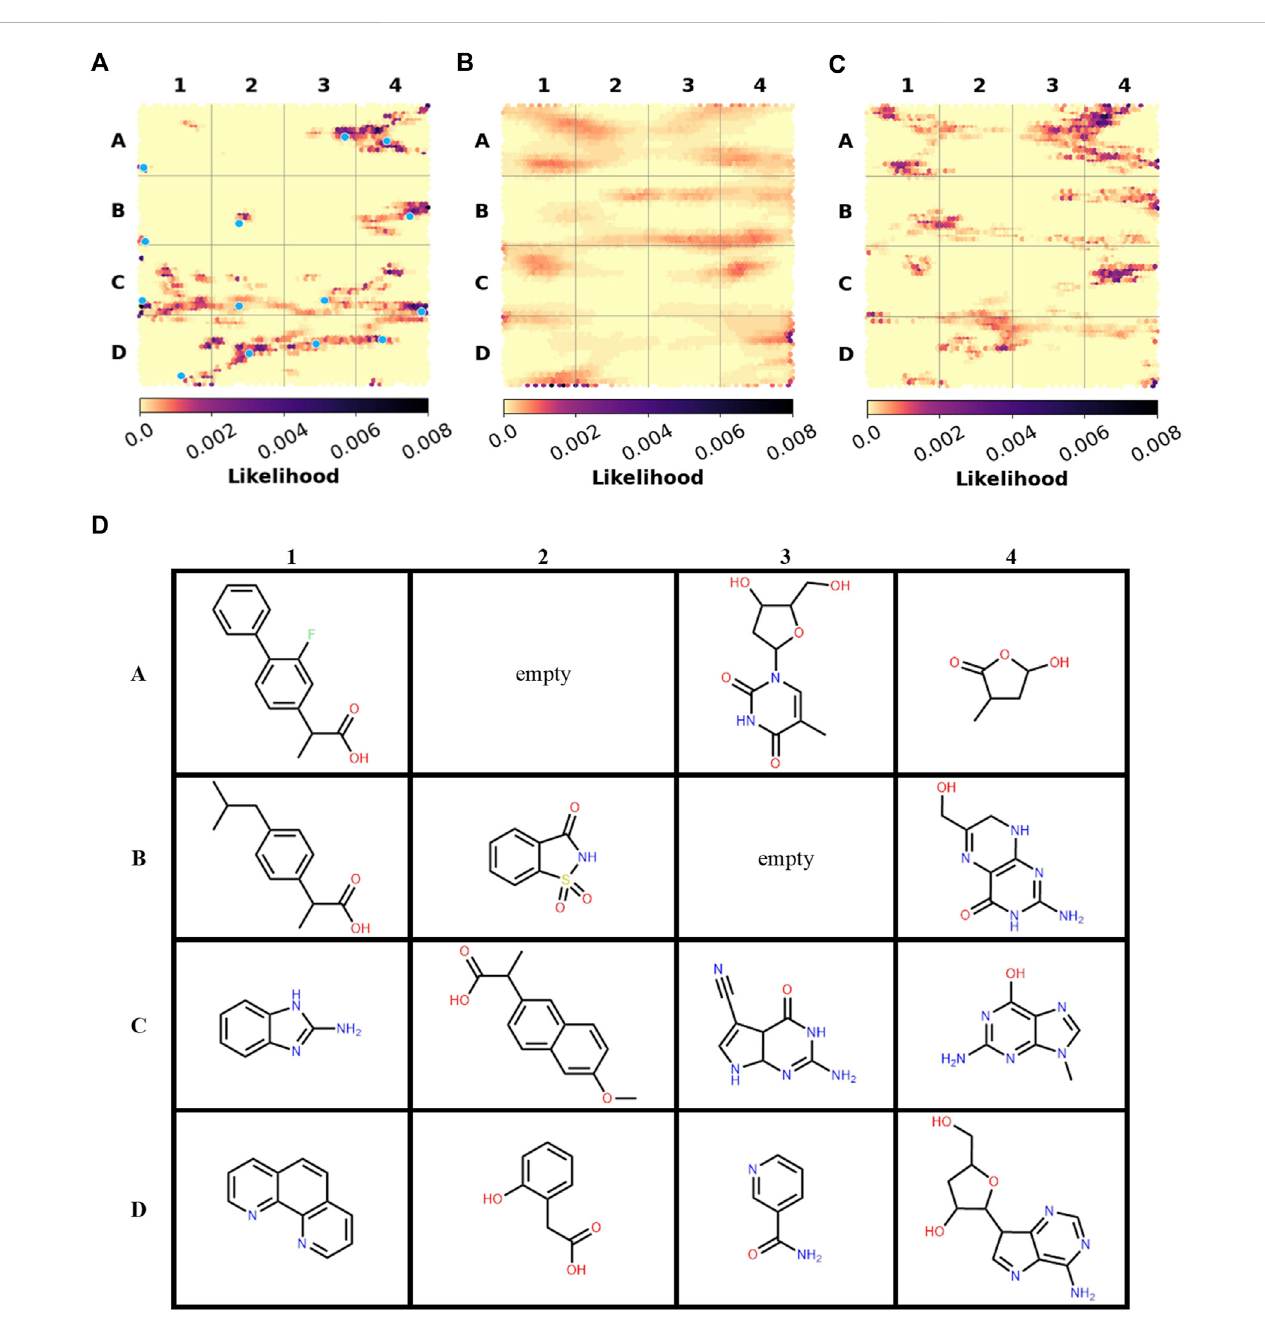
FIGURE 5 Spatial distribution of the fragments in GTM Landscapes (A) Versatile PDB fragments (B) All commercially-available fragments (C) Ensemble of nature- productlikecommercial libraries. (D) ExamplesofversatilePDBfragments.Theirprojectionpointsaremarkedwithbluedotsonthemap (A) .Figures5B,Care adapted from (Revillo Imbernon et al.,